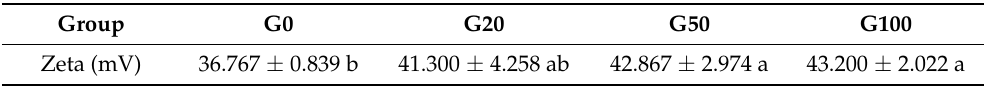
Figure 1. ( a ) Variation in absolute values of soil zeta potential with concentration of graphene. G0, G20, G50, and G100 indicate graphene concentration of 0, 20, 50, and 100 mg L −1 , respectively. ( b ) Stern double electric layer model. The values represent the mean ± SD (n = 9). Different lowercase letters indicate significant differences at p < 0.05. Table 1. Variation in absolute values of soil zeta potential with concentration of